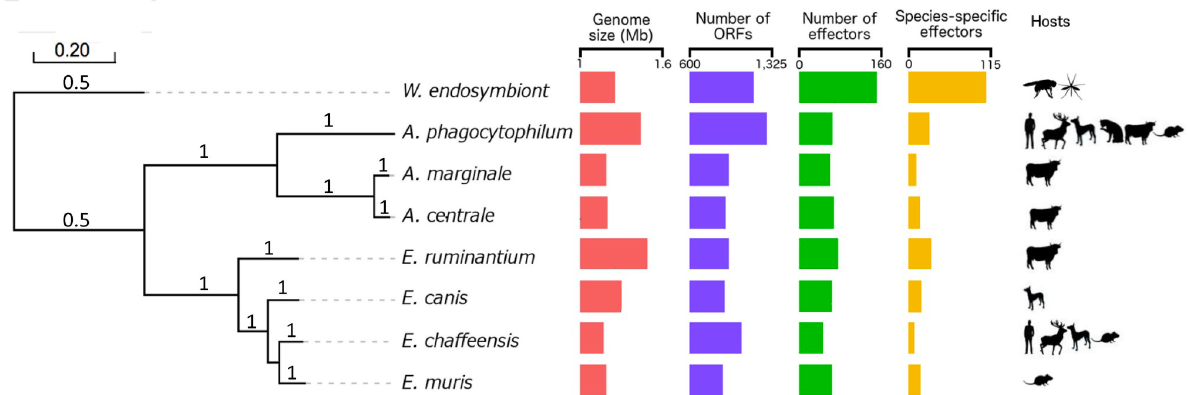
Fig 1. Phylogenetic tree of Ehrlichia and Anaplasma genus shows three different clades. A maximum likelihood tree of four Ehrlichia species ( E . chaffeensis str. Arkansas, E . canis str. Jake, E . muris AS145, E . ruminantium str. Gardel), three Anaplasma species ( A . phagocytophilum str. HZ, A . marginale str. Florida, A . centrale str. Israel) and W . endosymbiont of D . melanogaster (out group) was reconstructed on the basis of concatenated nucleic acid alignment of proteins shared by all species (core genomes) with 100 bootstrap resamplings. The following are represented for each bacterium: genome size (red), number of ORFs (blue), number of predicted T4 effectors (green), number of unique predicted effectors (yellow) and known major hosts (black